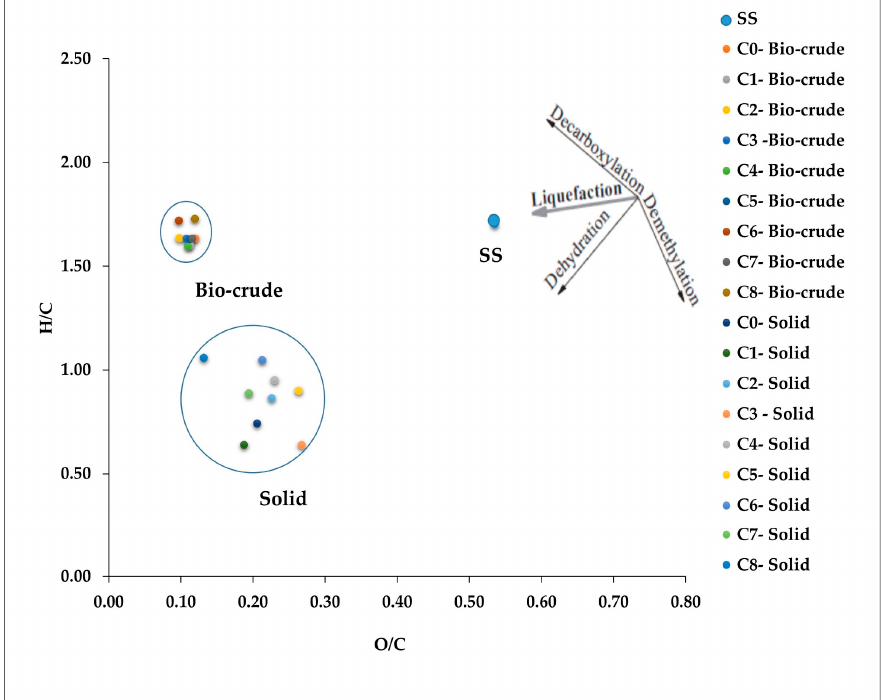
Figure 6. Van Krevelan diagram shows the pathways of liquefaction products.